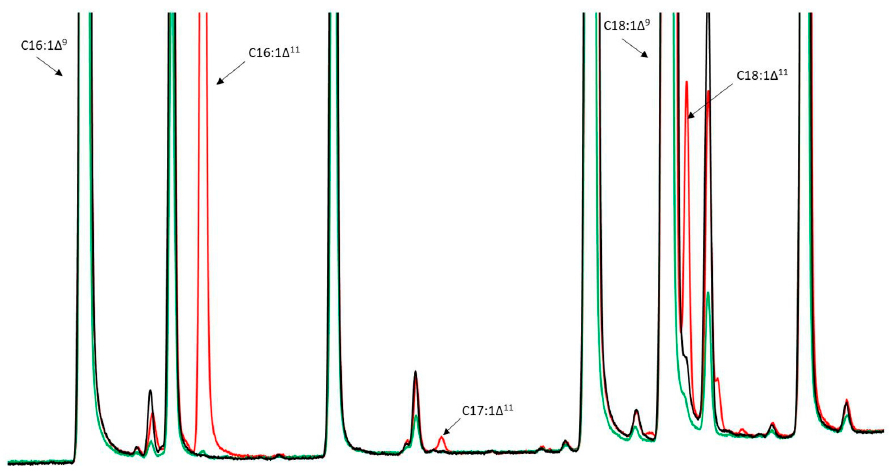
Figure 2. GC analysis of fatty acids in Y. lipolytica strains expressing MsexD2 and MsexD3 , grown on MedA + medium for 72 h. W29—wild-type strain (control), JMY6699 expressing MsexD2 and JMY6700 expressing MsexD3 .